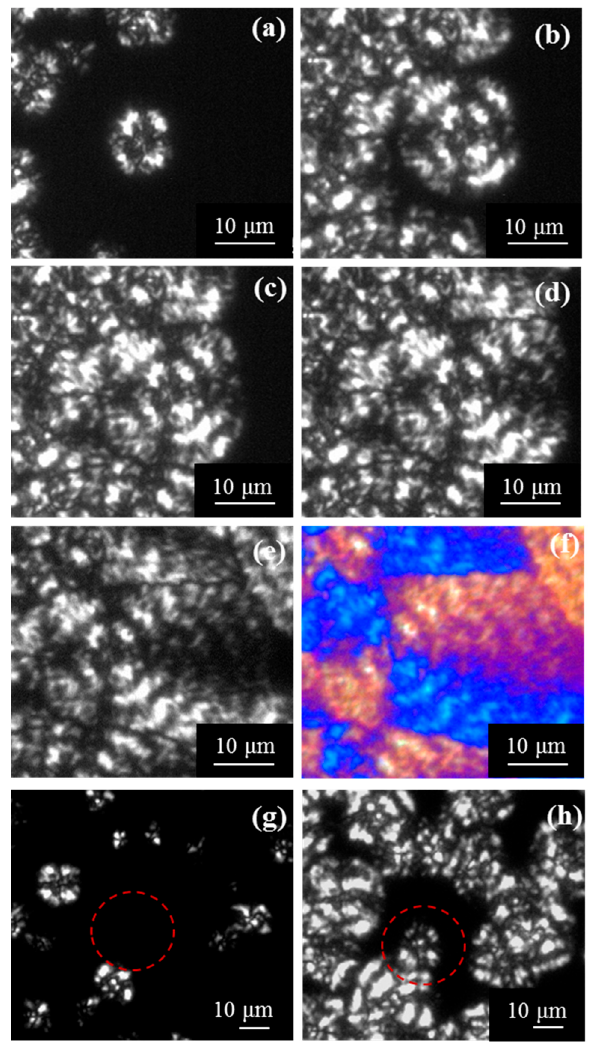
Figure 12. Optical micrographs showing P4HB spherulites crystallized at 47 °C for ( a ) 100 min, ( b ) 150 min, ( c ) 180 min, ( d ) 250 min, ( e ) 350 min and ( f ) 350 min. In the case of ( f ), the micrograph has been taken with a red tint plate. Comparison of micrographs taken after 47 min ( g ) and 80 min ( h ) for the crystallization performed at 46 °C. The dashed red circle points out the region where the apparition of a new spherulite is clear.